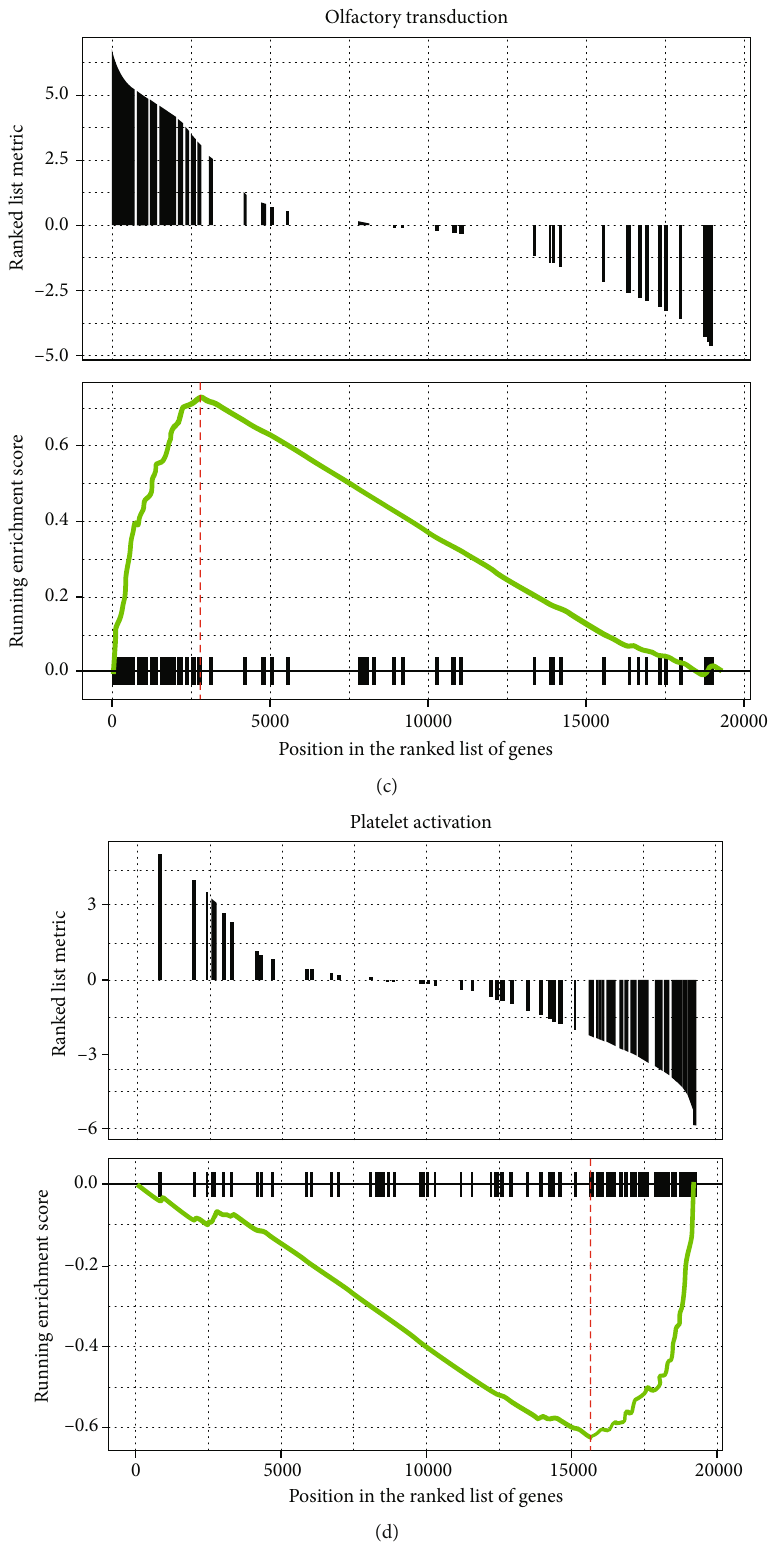
Figure 3: Gene set enrichment analysis results to identify crucial signaling pathways related to chronic kidney disease. (a, b) The dotplot and joyplot were constructed to visualize the up- and downregulated pathways associated to chronic kidney disease. (c, d) Representative enrichment map was visualized for pathway categories in chronic kidney disease, including upregulated pathway olfactory transduction and downregulated pathway platelet